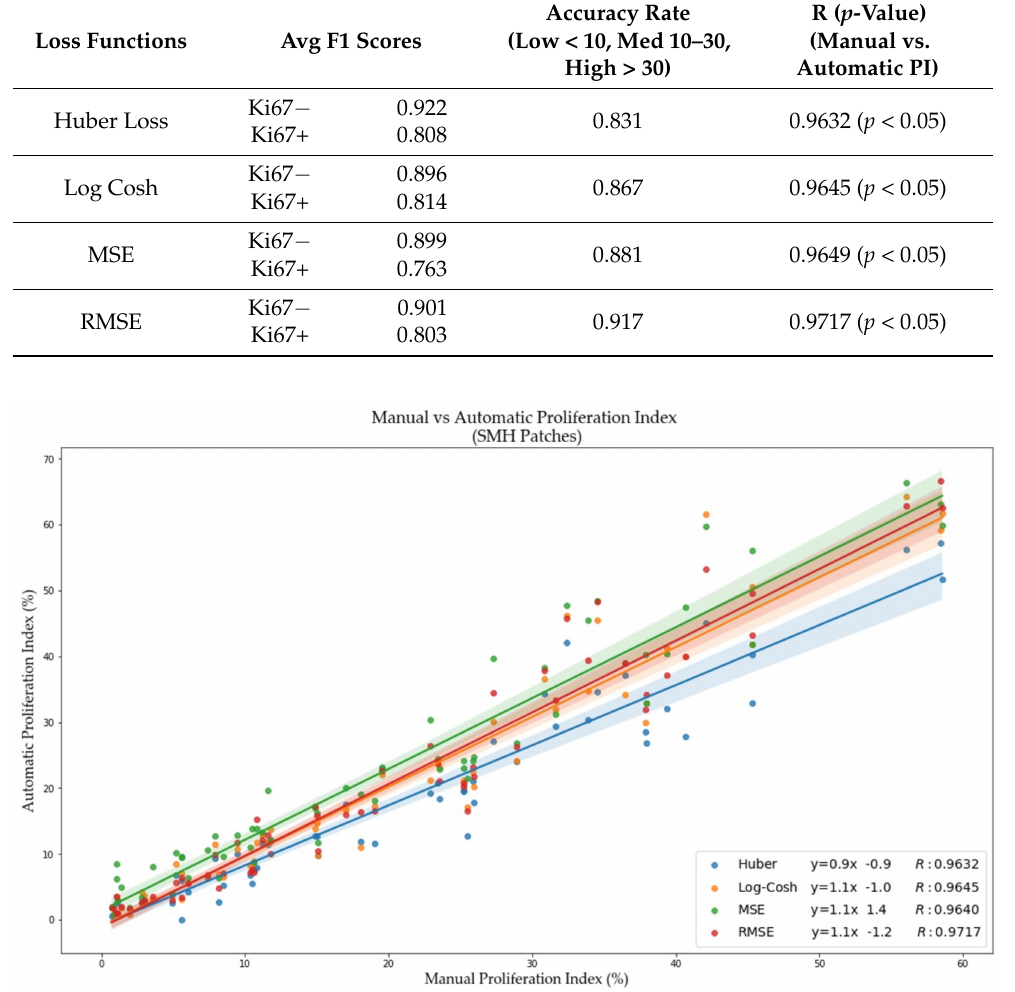
Figure 10. PI scatter plot of manual PI vs. automated PI for each regression-based loss function, with the corresponding Pearson Coefficient (R), and equation of the